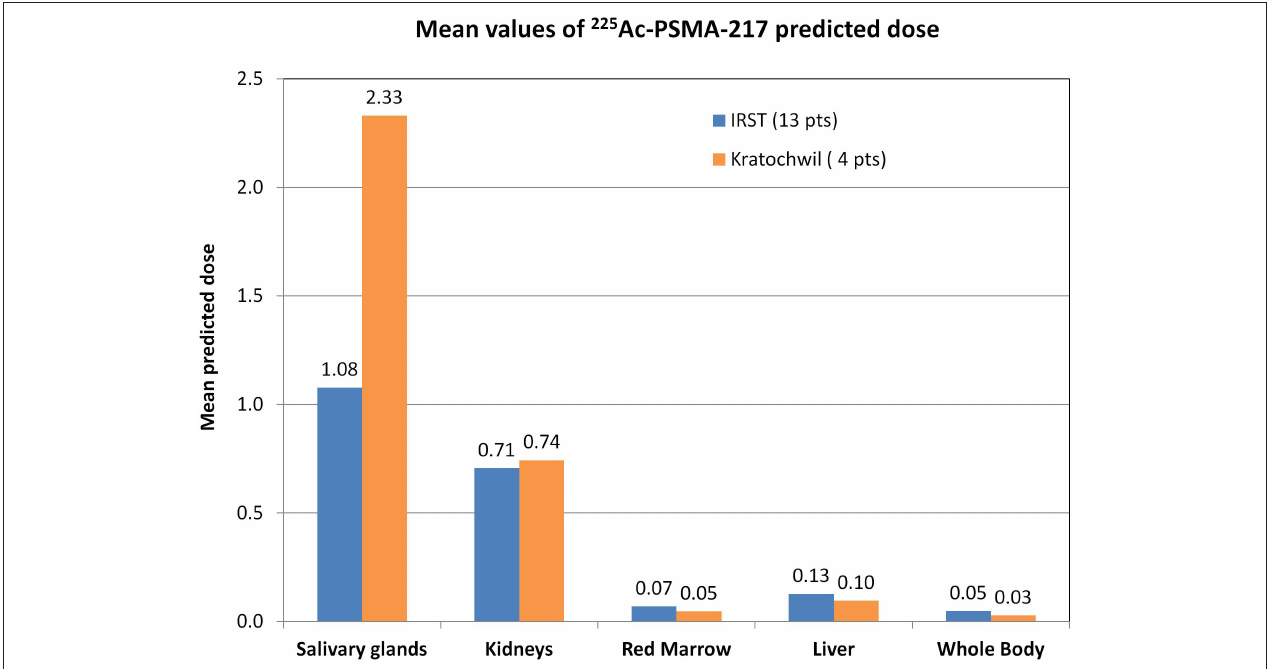
FIGURE 1 | Graphical comparison of our data (13 patients) with data published by Kratochwil et al. (8) (4 patients). Mean values of the predicted dose calculated for each patient group. Data were extracted from whole-body planar images and blood sample acquisition and analyzed in the same way. Our data are reported in Bd RBE5 /MBq, as suggested by the MIRD committee for deterministic effects (20), whereas data of Kratochwil et al.’s study (8) are reported in Sv RBE5 /MBq in accordance with their published paper.